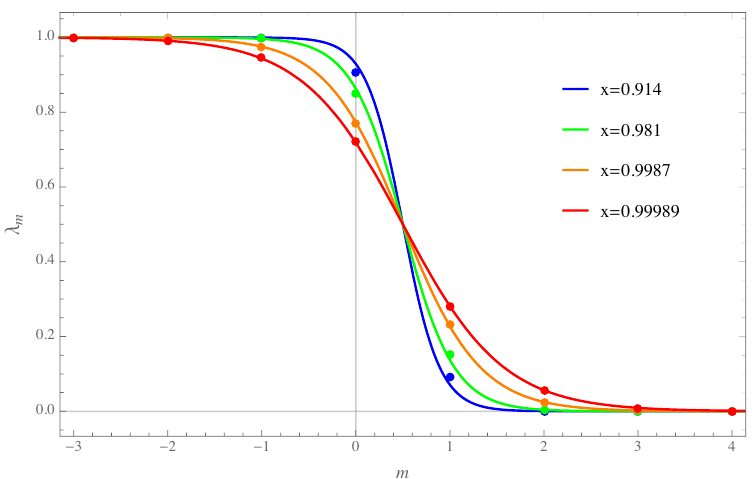
Figure 2 . Eigenvalues λ m of the correlation kernel obtained by numerical method (dots) versus the spectrum (4.21) of a thermal partition function with appropriate temperature (solid lines) for various x → 1 . Only the first few eigenvalues are shown. λ m are symmetric across m = 1 / 2 line. Although not shown in this figure, the discrepancy between analytics and numerics is well resolved by including the second order corrections, see figure 5.